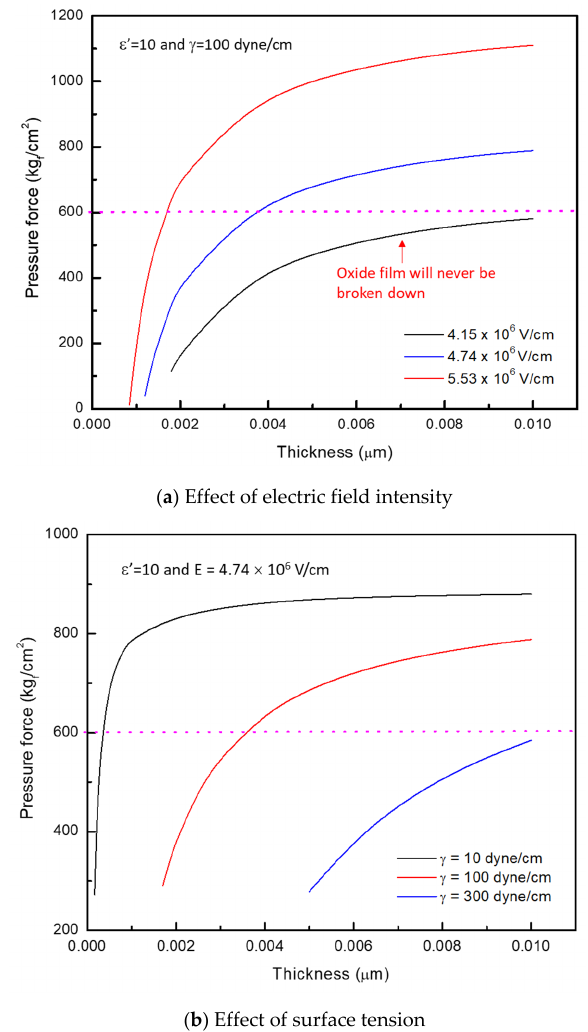
Figure 5. The effect of electric field intensity and surface tension on film breakdown, Figure 5. The e ff ect of electric field intensity and surface tension on film breakdown, redrawn from [35]. redrawn from [35] . Reproduced with permission from N. Sato, Vol. 16, 1683–1692, Reproduced with permission from N. Sato, Vol. 16, 1683–1692, Electrochimica Acta; published by Electrochimica Acta; published by Elsevier, October 1971.